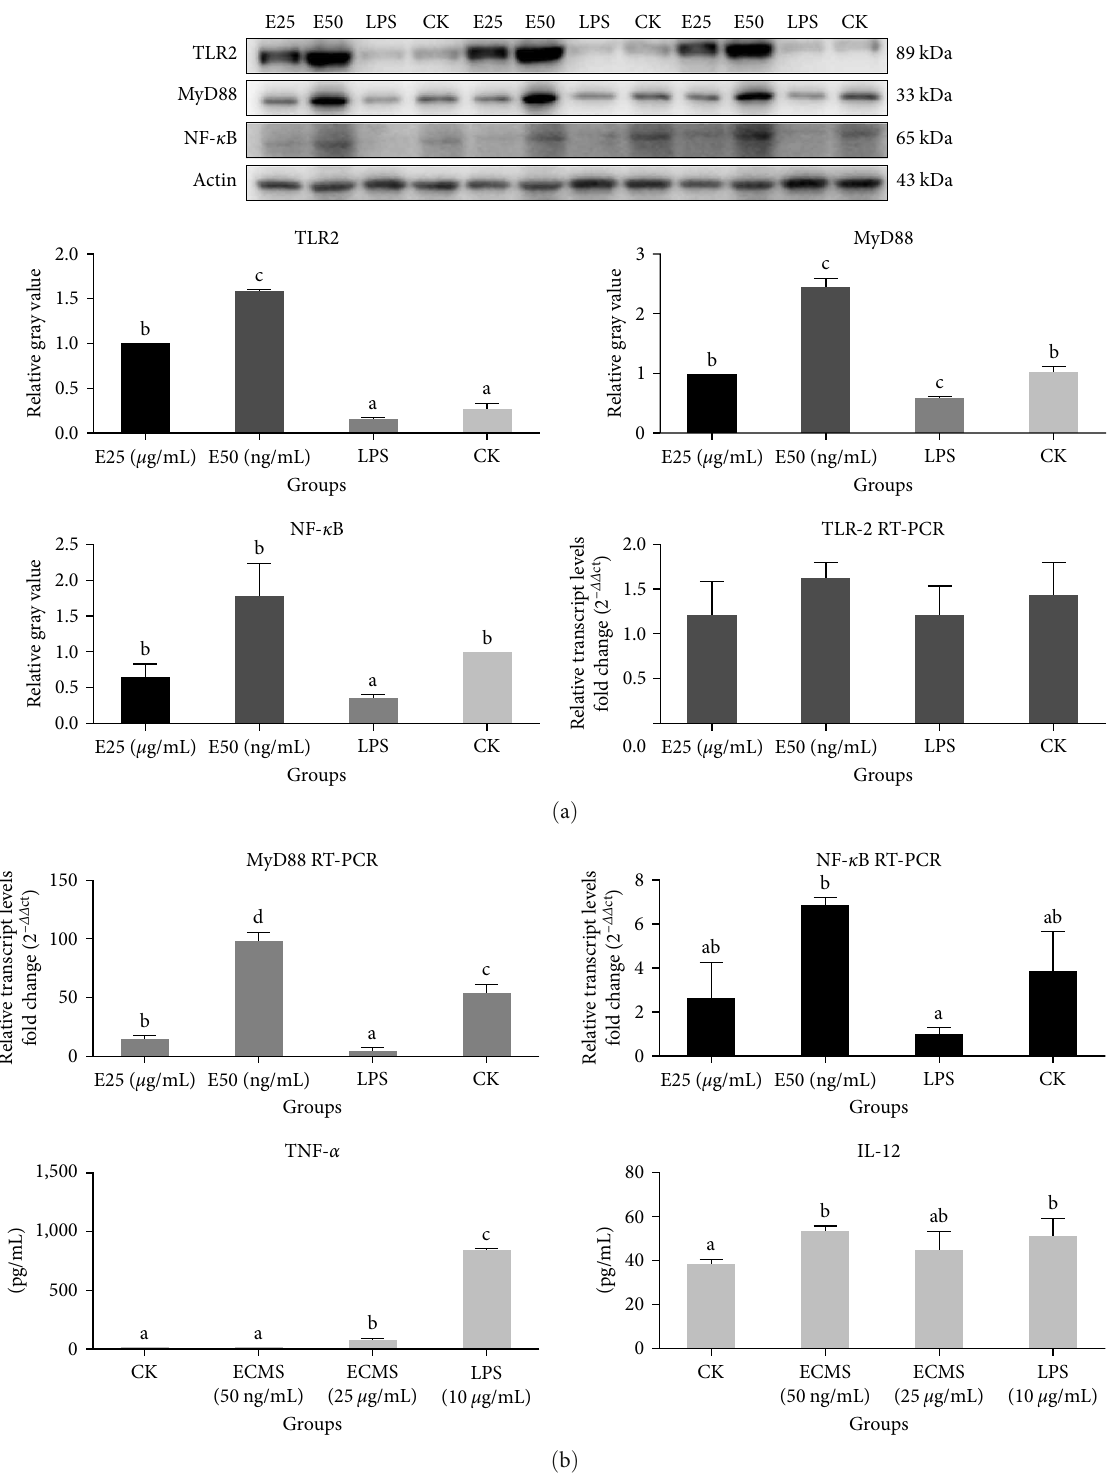
F IGURE 4: The results of western blot TLR2, MyD88, NF- κ B, and TNF- α , IL-12 concentration from Raw264.7 cell supernatant. Different letters above the bar indicate the presence of signi fi cant differences among the groups ( P < 0 : 05). The horizontal and vertical coordinates of the graph stand for the level of cytokines and different groups in (a). The horizontal and vertical coordinates of the graph stand for the relative transcript levels of cytokines and different groups in (b) or level of cytokines and different groups in (b). Western blot analysis revealed that induction with 50ng/mL or 25 μ g/mL ECMS led to an increased expression of TLR2, while the expression of MyD88 and NF- κ B was increased in the macrophages induced with 50ng/mL ECMS (a). RT-PCR assay showed that while MyD88 expression was increased in ECMS-induced macrophages (50 ng/mL) as compared to cells in any other groups ( P < 0 : 05), the expression level of NF- κ B in ECMS-induced macrophages (50 ng/mL) was higher than that in lipopolysaccharide group ( P < 0 : 05)